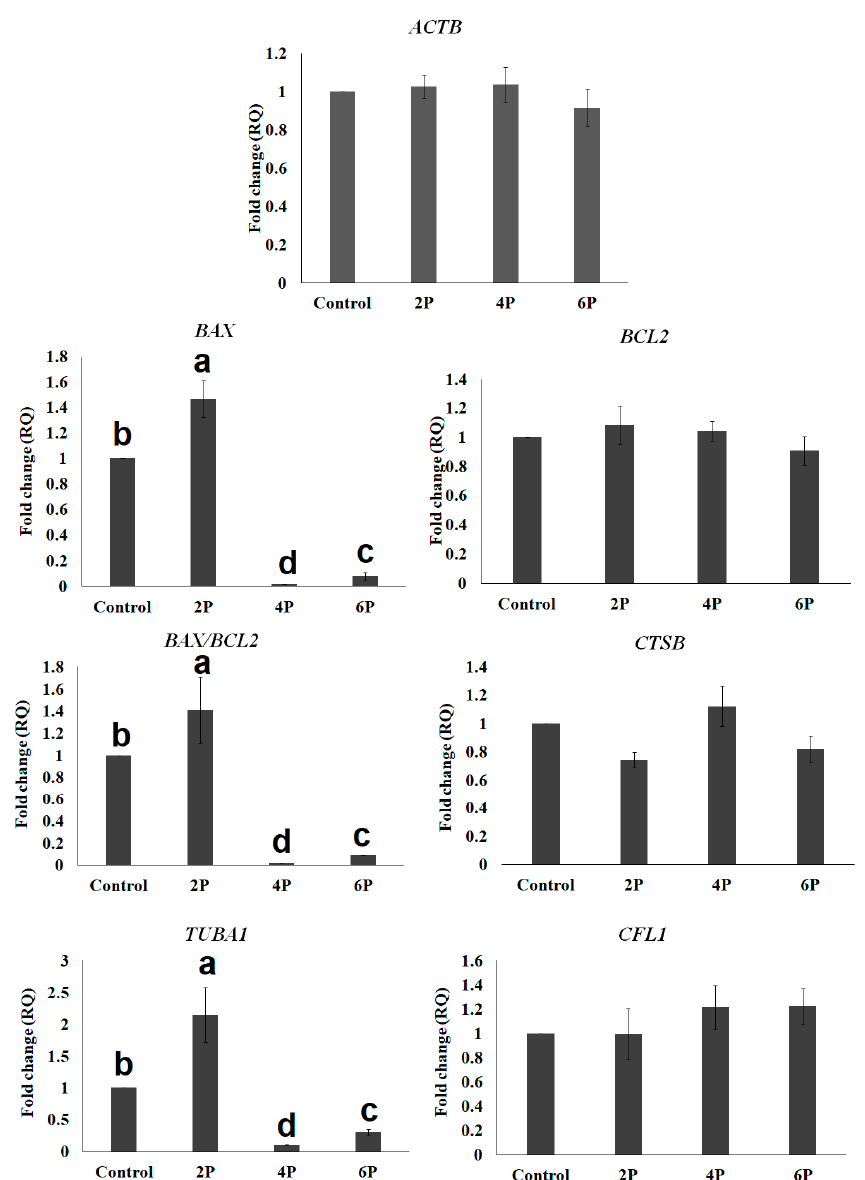
Figure 5. E ff ect of pre-IVM ROCK-inhibitor supplementation (2 h, 4 h, and 6 h) on the cytokinesis- and apoptosis-related mRNA transcripts of mature camel COCs. Values were compared to the control groups (without ROCK inhibitor). Values carrying di ff erent letters (a, b, c, and d) indicate significant di ff erences ( p > 0.05) between the values. ACTB : beta ( β )-actin protein gene, BCL2 : B-cell lymphoma-2 (Apoptosis regulator, antiapoptotic), BAX : Proapoptotic, BAX / BCL2: shows the susceptibility to death by apoptosis , CTSB : Encodes cathepsin B enzyme which induces apoptosis through the stimulation of Caspase 3, TUBA1 : Encodes alpha-tubulin ( α -tubulin), CFL1 : Encodes cofilin.